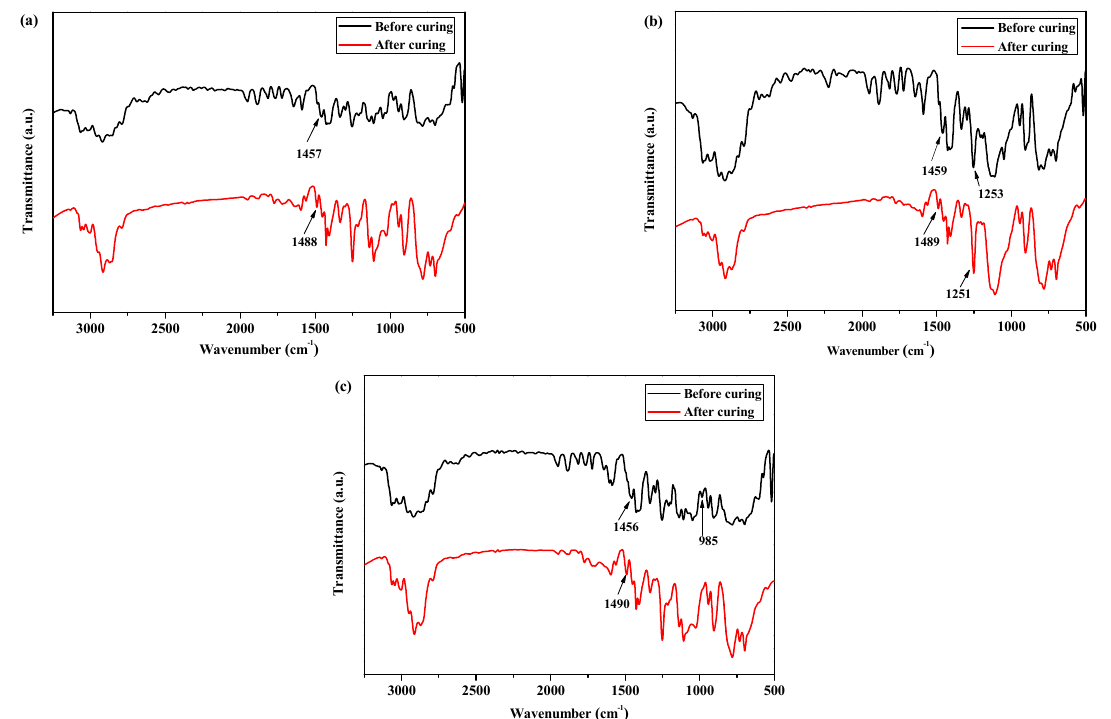
Figure 2. The FTIR spectra of ( a ) P(4-MB-co-1-MP), ( b ) P(4-MB-co-1-MP)/BCB-POSS, and ( c ) P(4-MB-co-1-MP)/DVS-BCB before and after curing.